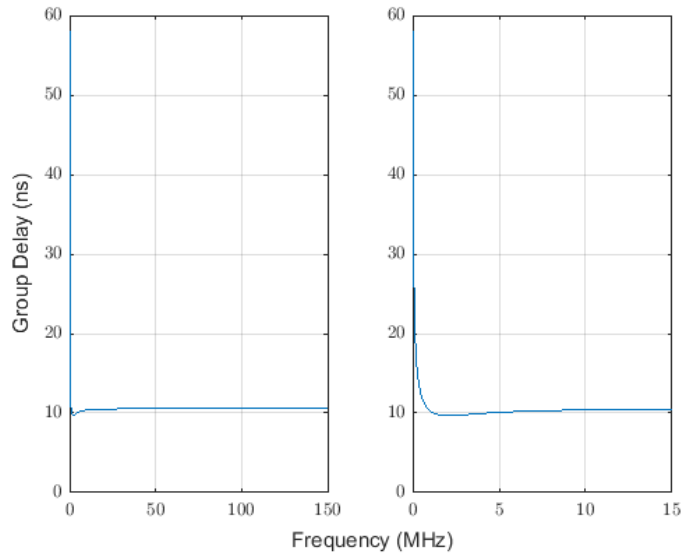
Figure 13. The group delay per meter soil for µ r = 1, (cid:101) r = 10, and σ = 0.002 S/m. The two plots are the same; the right plot better shows the lowest